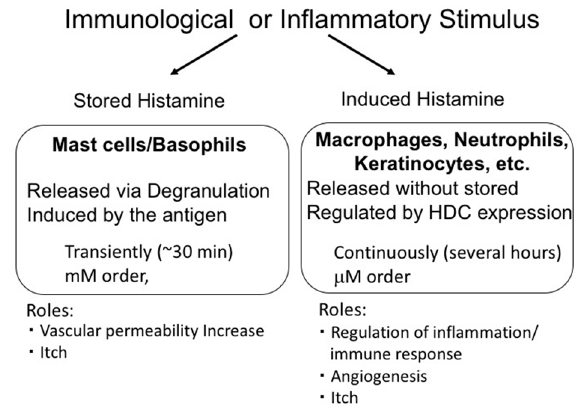
Figure 1. Difference between stored histamine and induced histamine.